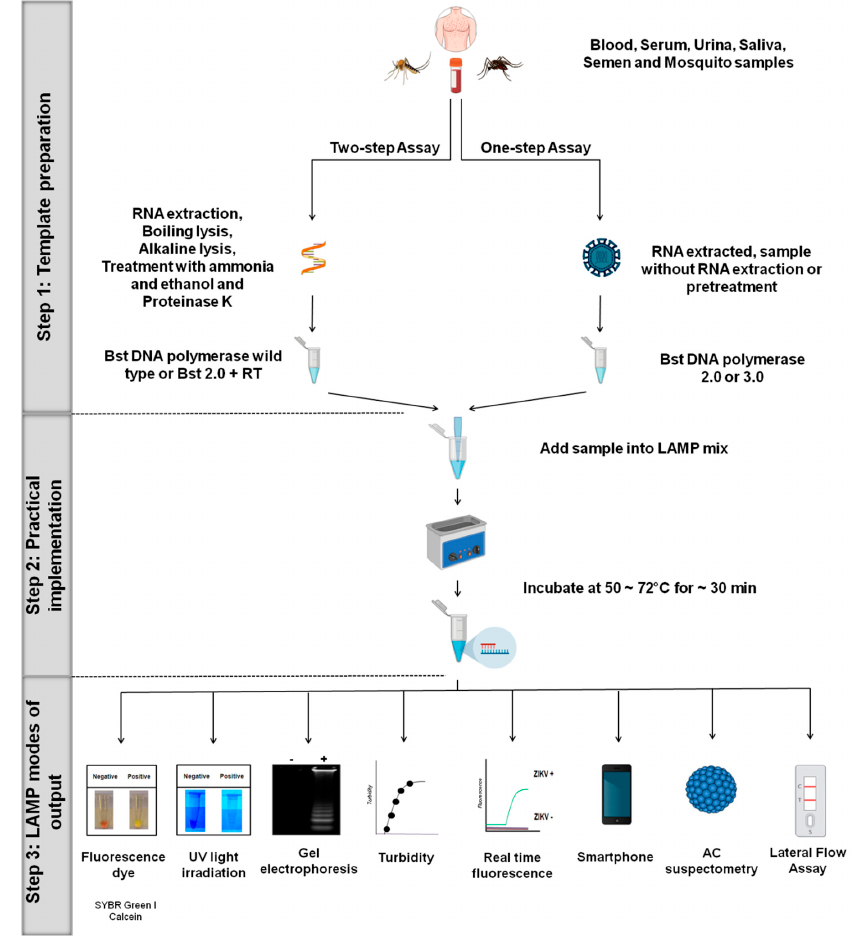
Figure 2. LAMP platforms for ZIKV. Overview of the different LAMP systems for ZIKV, including one-step and two-step protocols. In general, LAMP assays include variations in one of the major three steps: ( 1 ) Template preparation, ( 2 ) practical implementation, and ( 3 ) LAMP modes of